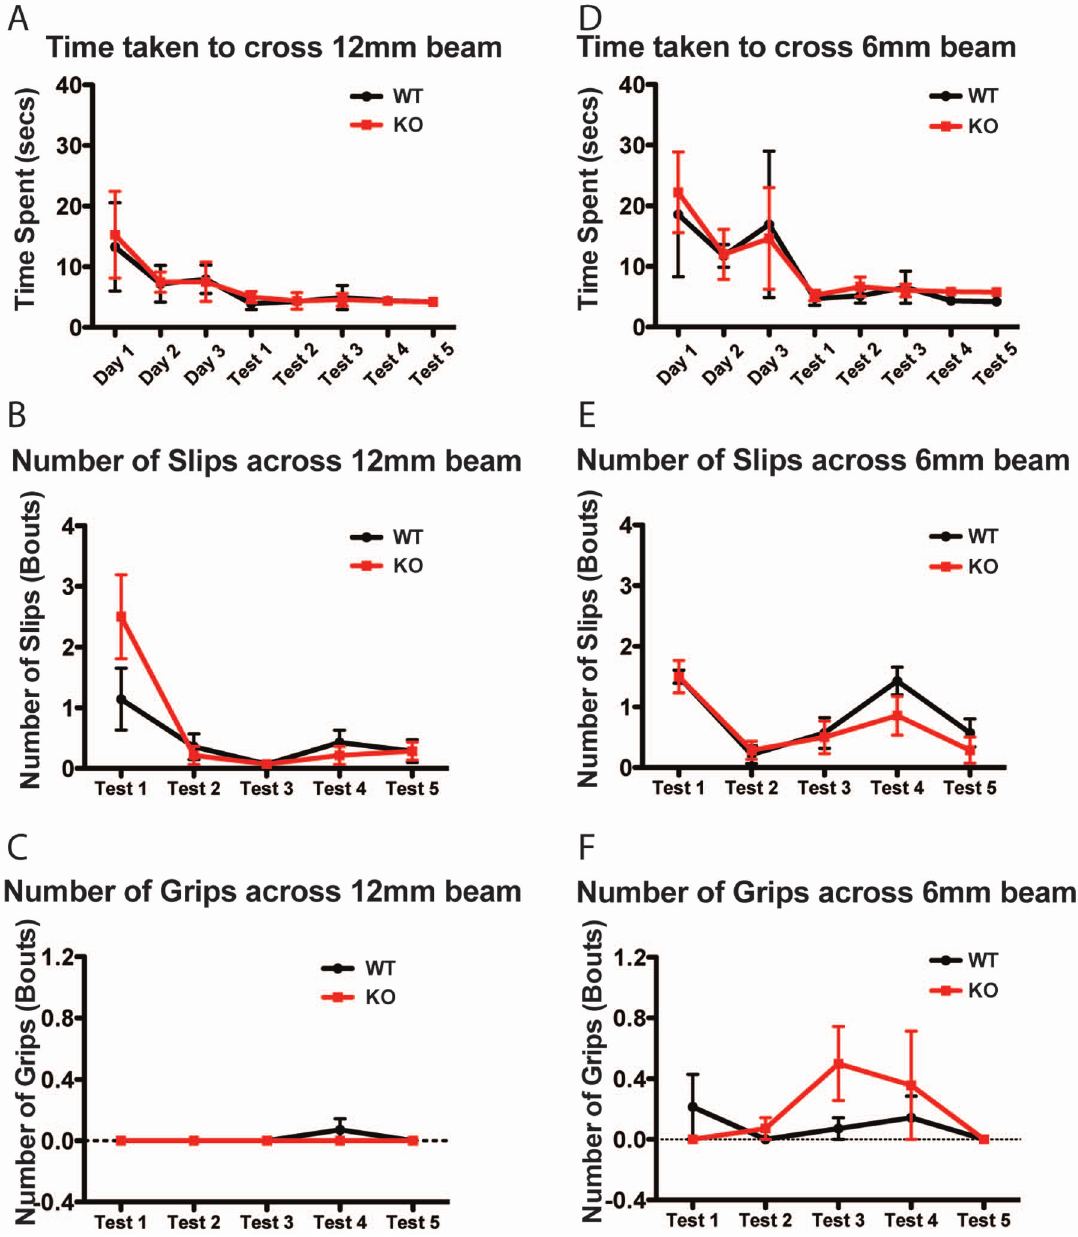
Figure 1. ANP32E-deficient mice perform normally on balance beam assay. Mice were assayed, on light aversion balance beam across a 12 mm diameter dowel (panels A–C) and a 6 mm diameter dowel (panels D–F), for crossing time (panel A and D), number of slips (panels B and E) and number of grips (panels C and F). No statistically significant differences were detected between Anp32e 2 / 2 (KO, red) and Anp32e + / + (WT, black).